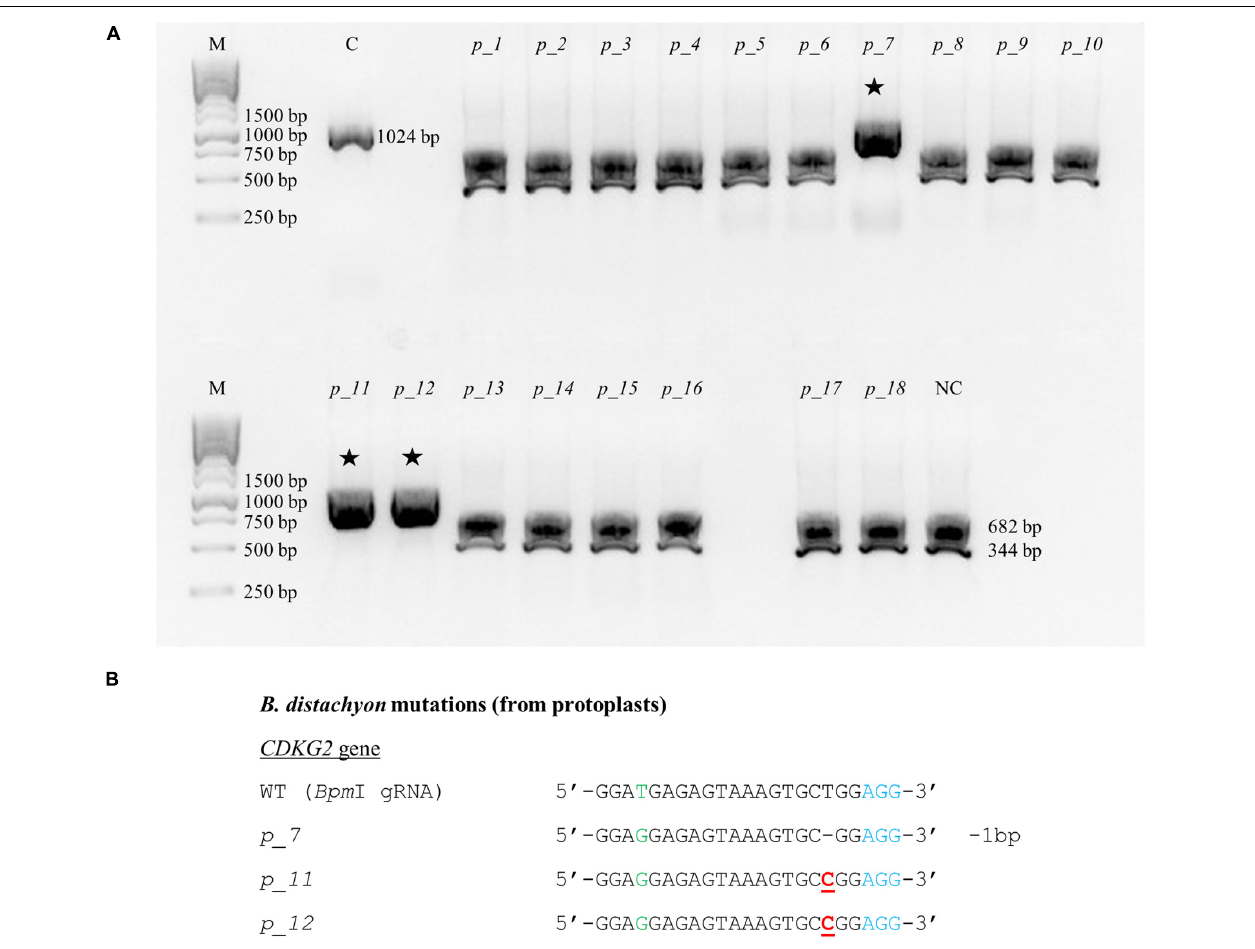
FIGURE 6 | Example of the nature of mutations obtained using CRISPR/Cas9 targeted mutagenesis with Bpm I gRNA in Bd21 protoplasts. (A) Analysis of the obtained colonies using PCR/RE assay and gel electrophoresis. Lane M, molecular weight marker, lane C, control – undigested PCR product, lanes p_1 – p_18, analyzed colonies obtained during the transient protoplast assay, lane NC, negative control – the PCR product from the WT plant digested using Bpm I restriction enzyme. bp – base pairs. Edited sequences are indicated by asterisks. (B) Results of sequencing of plasmids from individual colonies. Deletions are denoted as hyphens (-) and substitutions as bold, underlined red letters. The PAM sequence is shown in blue. SNP in the target sequence of Bd and Bs genomes is shown in green. bp – base pairs.